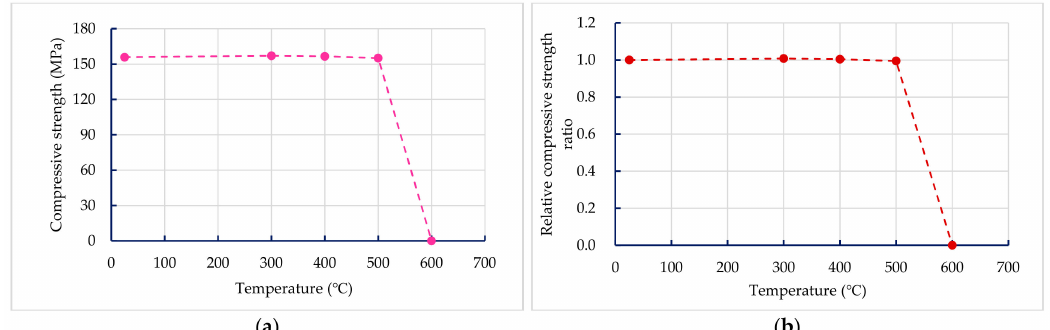
Figure 10. Comparison of compressive strength before and after fire damage to the UHPC-1 specimen: ( a ) residual compressive strength after high temperature; ( b ) relative compressive strength